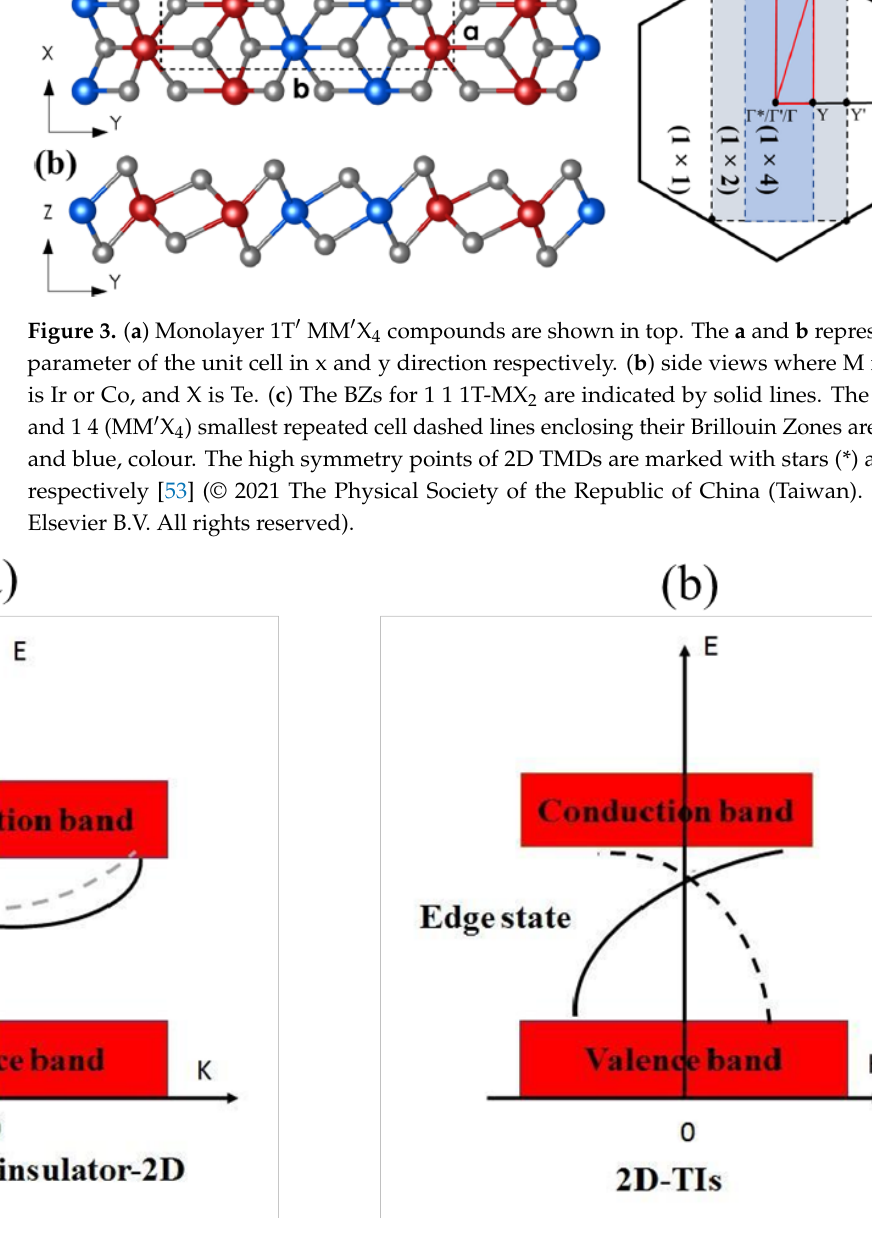
Figure 4. Edge states visualization in 2D TIs. ( a ) Ordinary insulator-2D; ( b ) 2D-TIs.